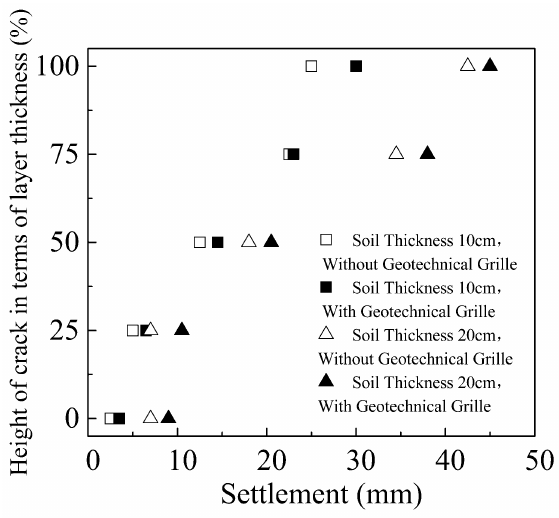
Figure 5. Relationship between settlement and crack development.